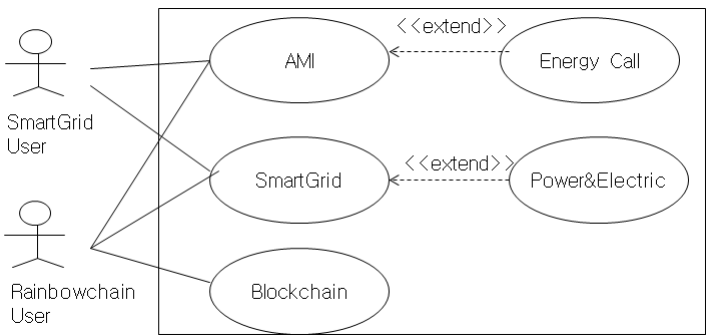
Figure 6. Rainbowchain use ‐ case diagram.